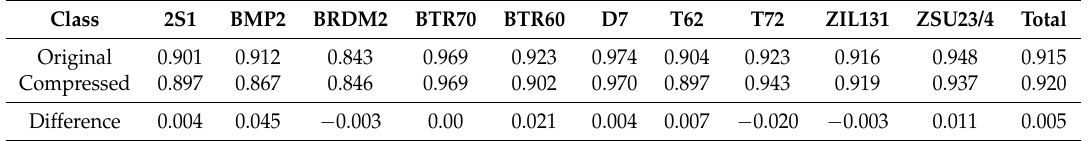
Table 7. 10-class recognition accuracy comparison of original network and compressed